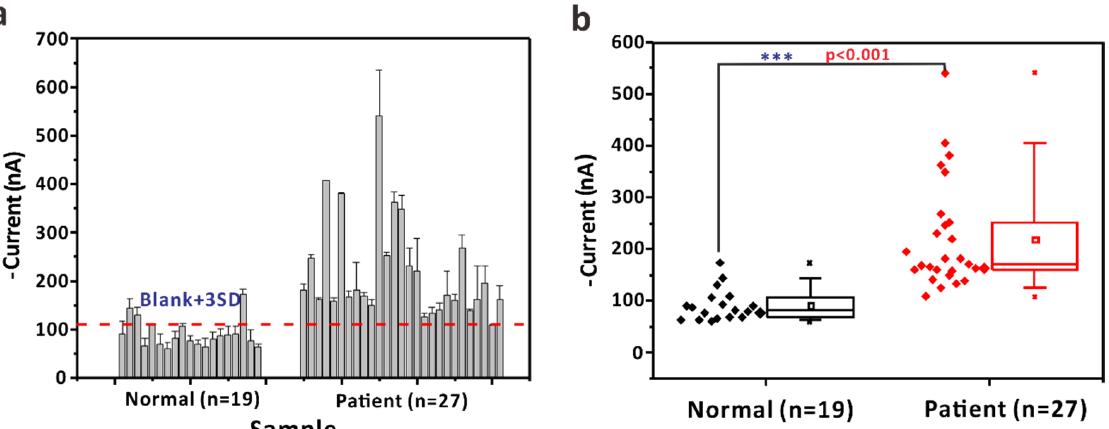
Figure 4. ( a ) Clinical sample detection with the EIC biosensor chip of healthy controls ( n = 19) and prostate cancer patients ( n = 27). ( b ) Box plots showing the estimated levels of PSA in the serum. Statistical analysis was performed by means of one–way analysis of variance (ANOVA). *** p < 0.001.